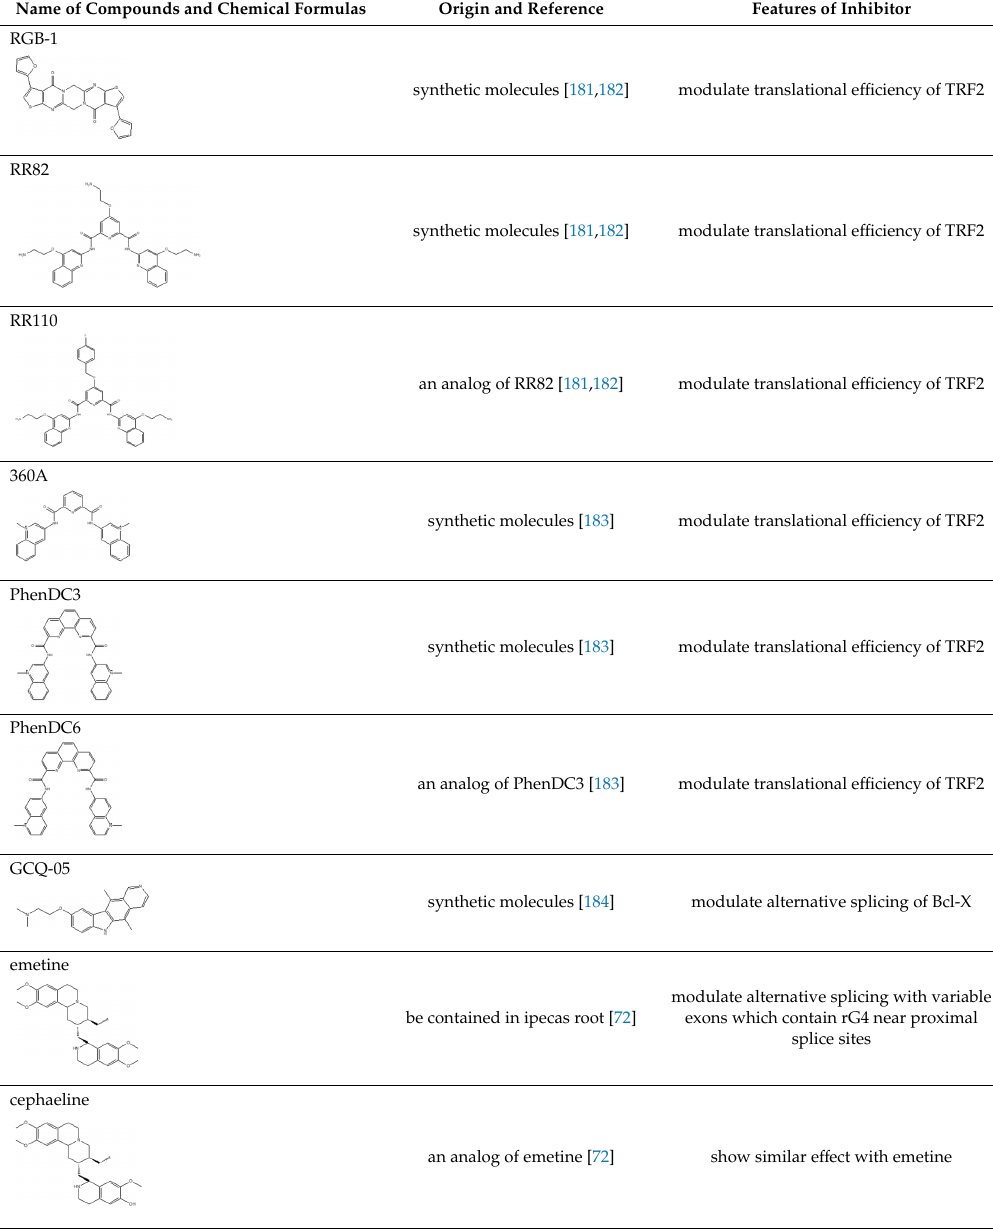
Table 2. Modulators of G-quadroplex which control translation or splicing.